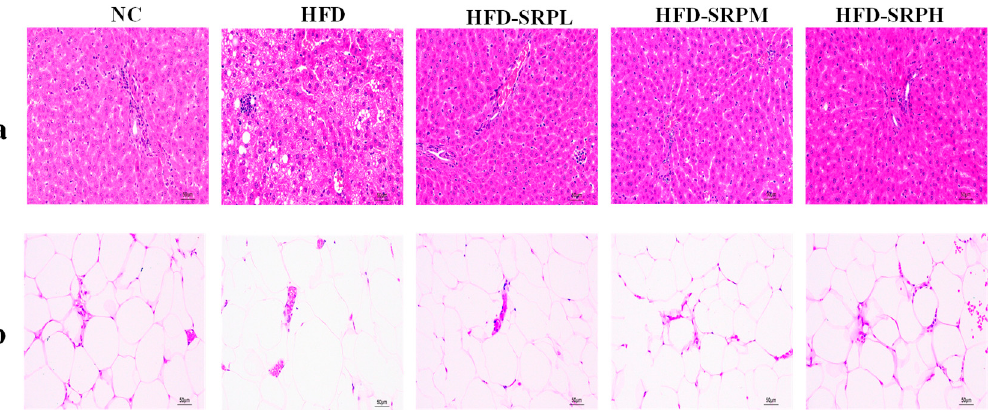
Figure 2. Pathological sections of liver and white adipose tissue were stained with HE (×200). ( a ) Liver tissue. ( b ) White adipose tissue. ( a ) Liver tissue. ( b ) White adipose